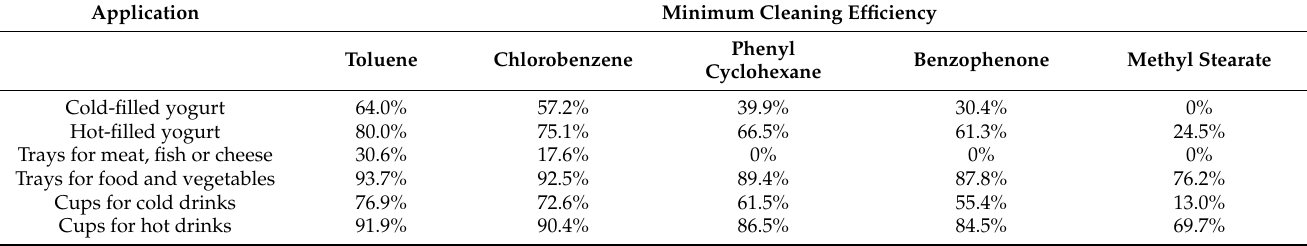
Table 4. Minimum cleaning efficiencies for the super-clean recycling process for the applications given in Table 2 (over-estimative for the calculation is factor of 5 as applied by EFSA for low diffusive